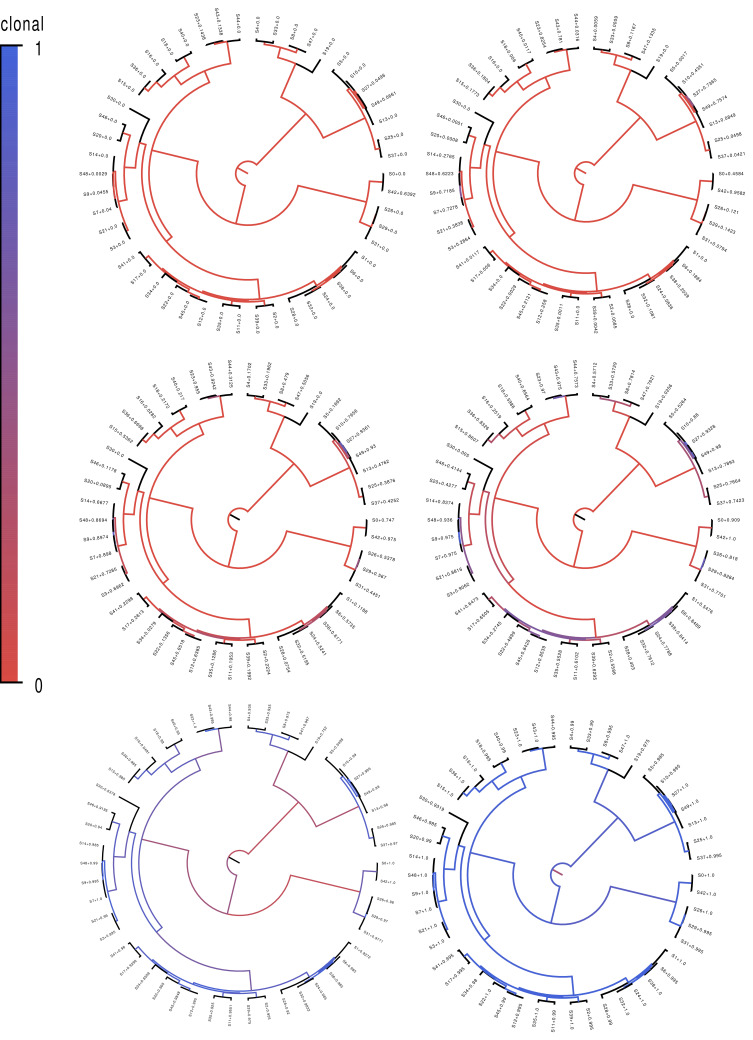
Fractions of positions that are clonally inherited (not affected by recombination) along each branch of the clonal phylogeny for the simulated datasets. Each panel shows the clonal phylogeny with the color of the branches indicating what fraction of positions were clonally inherited from all (blue) to none (red) along that branch. Panels correspond, from top-left to bottom-right, to recombination to mutation rates of ρ/μ equalling 10, 1, 0.3, 0.1, 0.01, and 0.001. The fractions at the leaves indicate the fraction of the genome that was clonally inherited along each terminal branch.